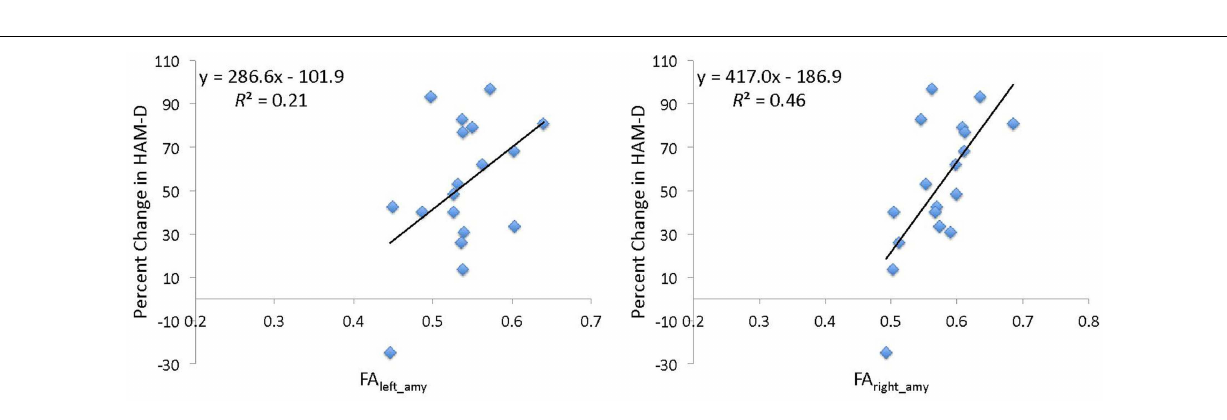
FIGURE 3 | Percent change in Hamilton depression scale score (HAM-D) as a function of pre-treatment average fractional anisotropy. Average fractional anisotropy (FA) was calculated using a weighted mean